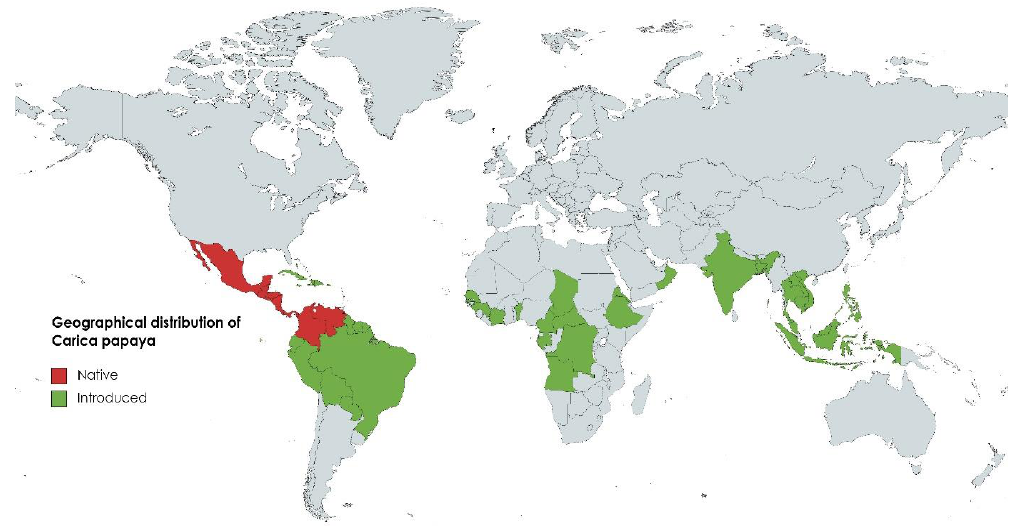
Fig. 1. Geographical distribution of C. papaya